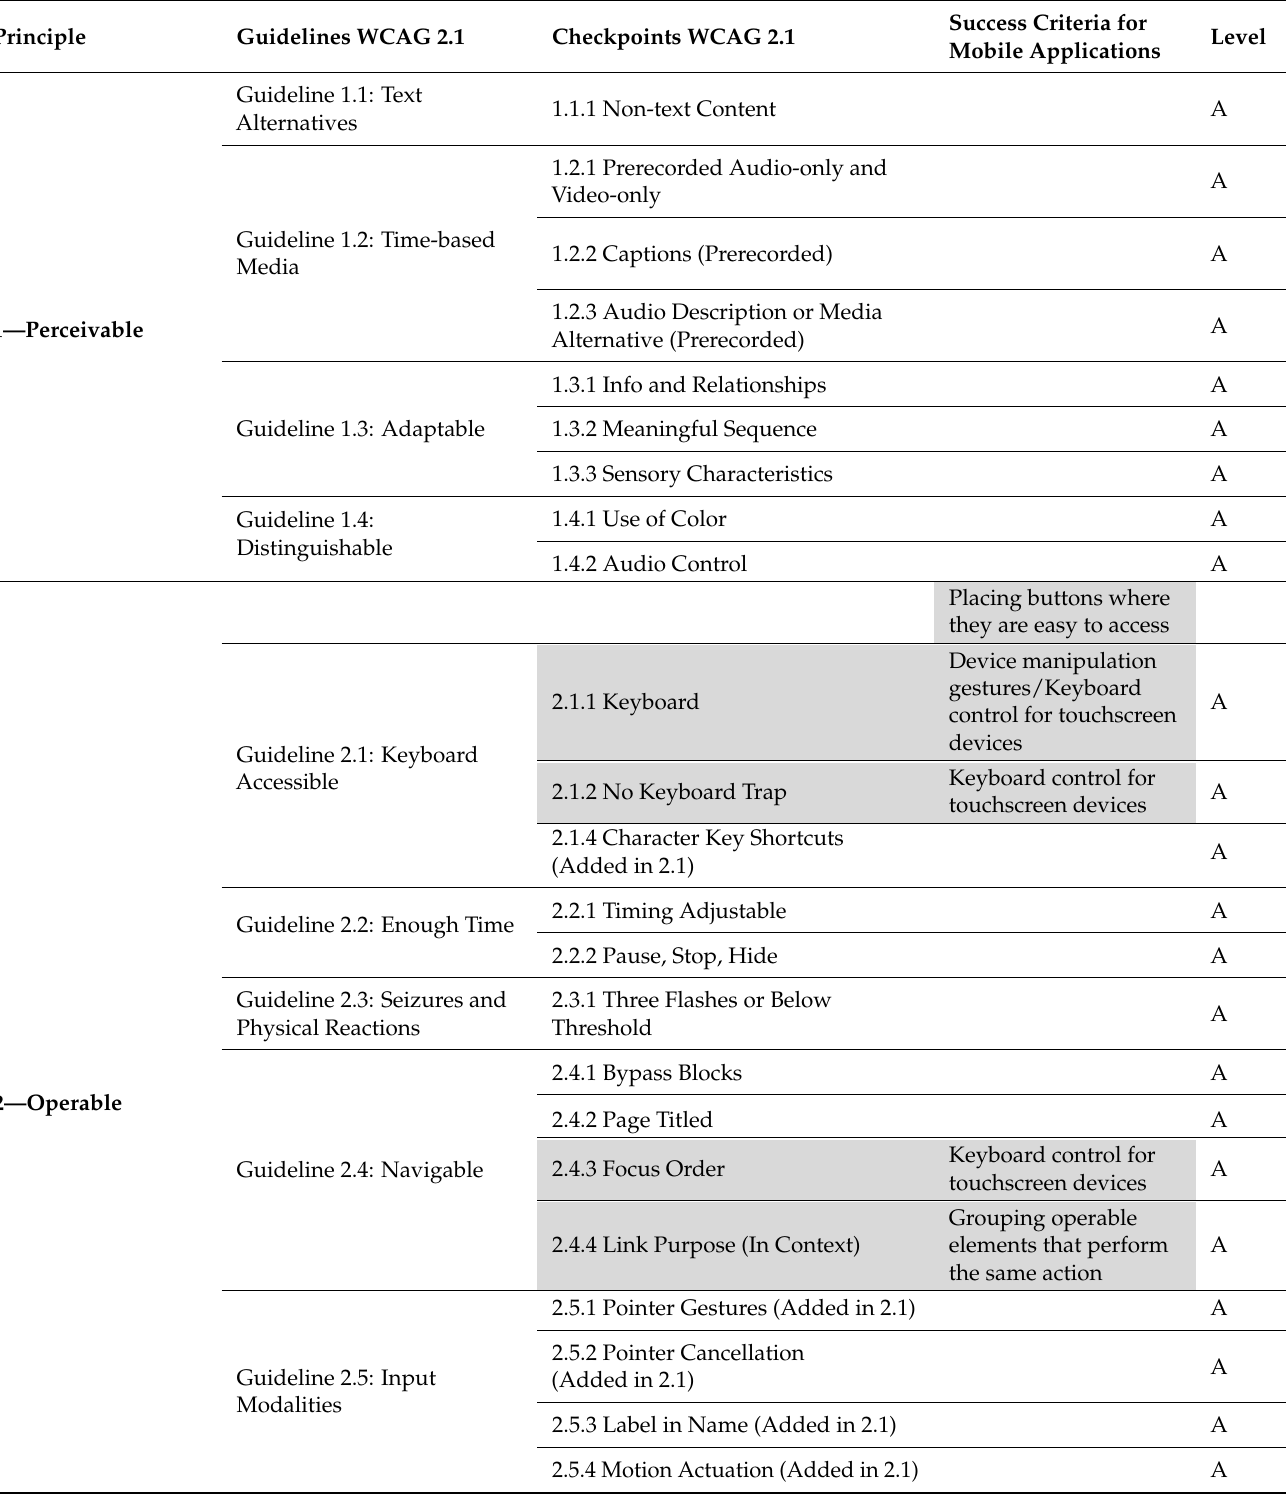
Table A6. Web Content Accessibility Guidelines 2.1 (level A) and other W3C/WAI Guidelines apply to mobile.